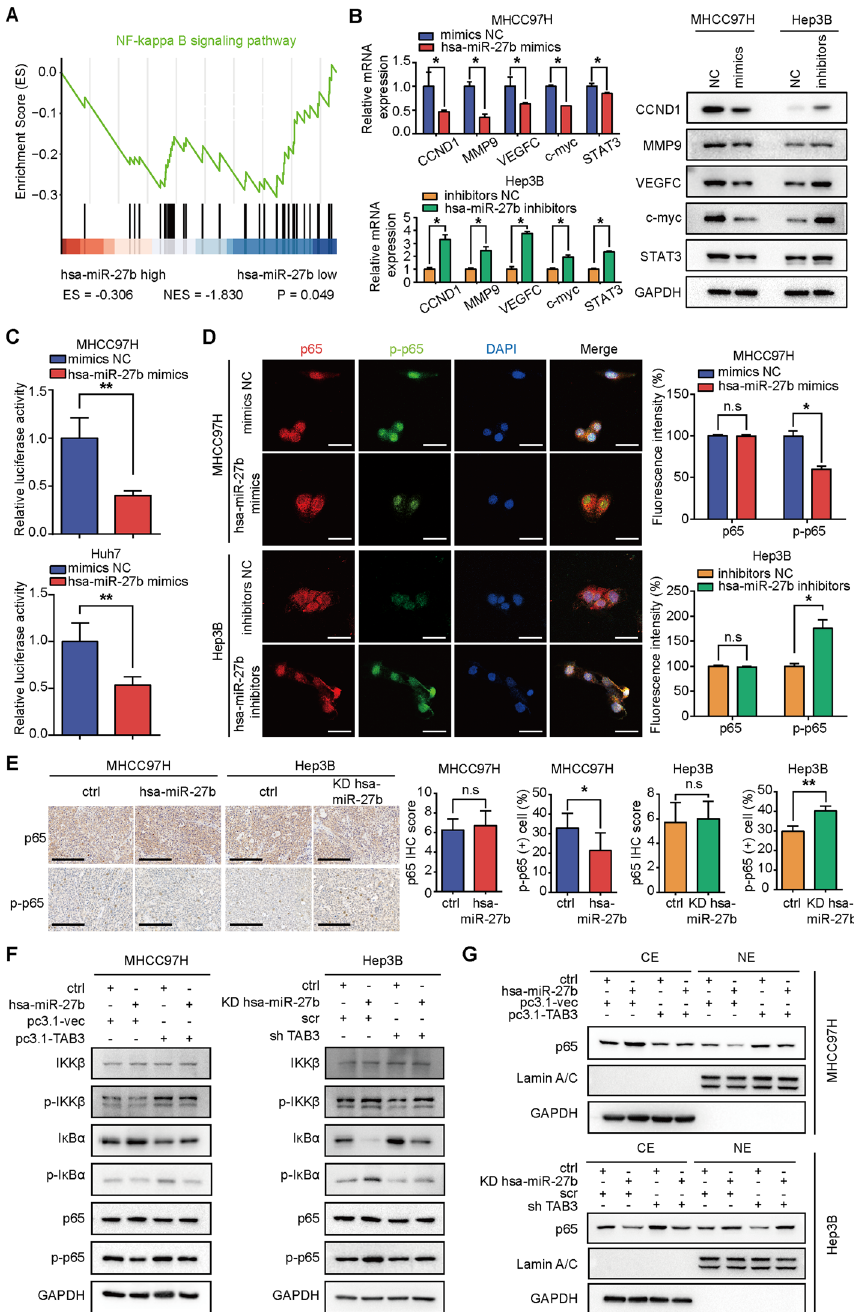
Fig. 6 (See legend on previous